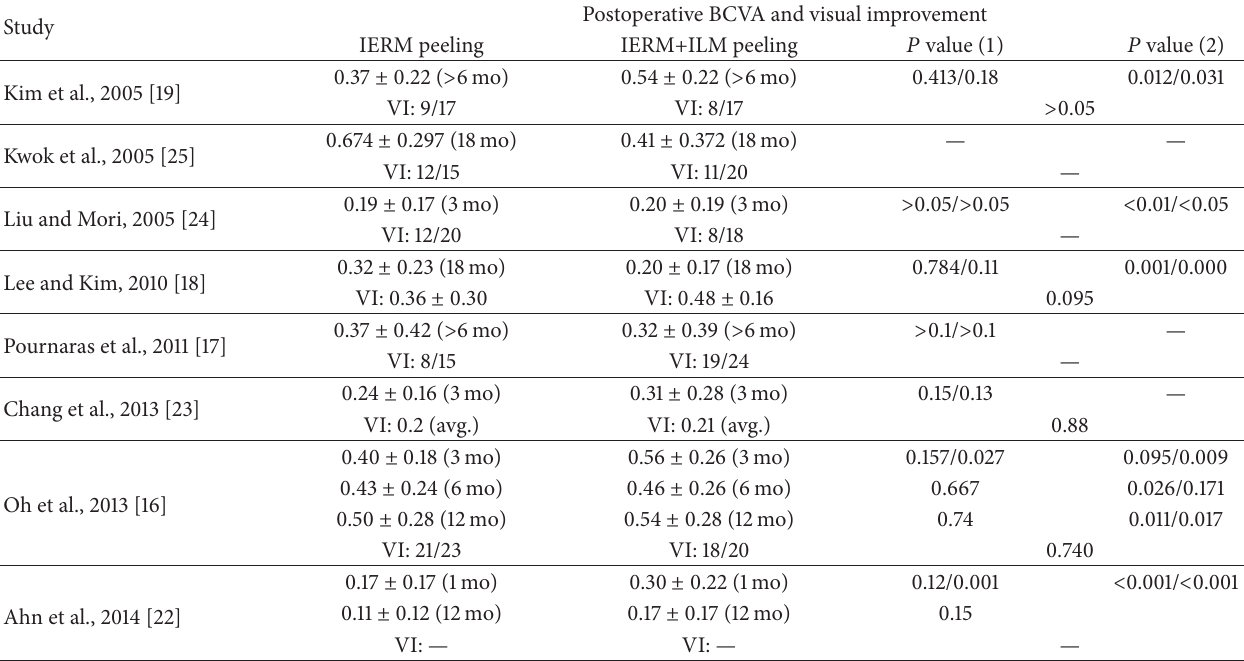
Table 4: Postoperative best-corrected visual acuity (logMAR) and vision improvement (VI).